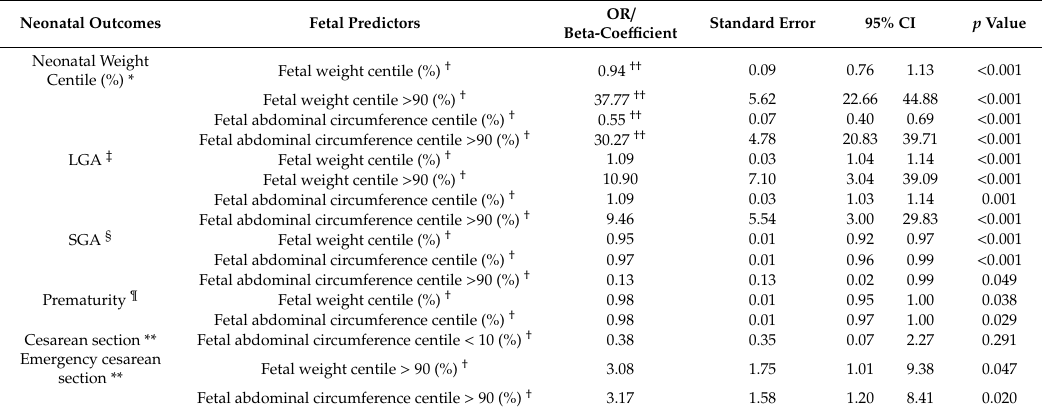
Table 2. Fetal predictors of adverse neonatal outcomes after adjustment for maternal predictors.